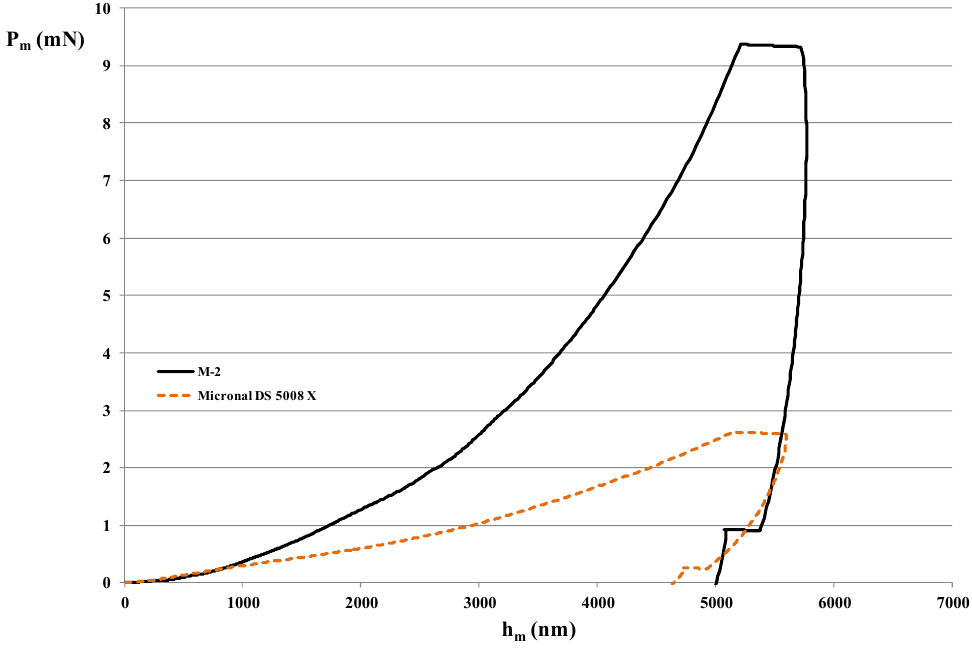
Figure 5. h m vs. P m , comparison of the samples under study.